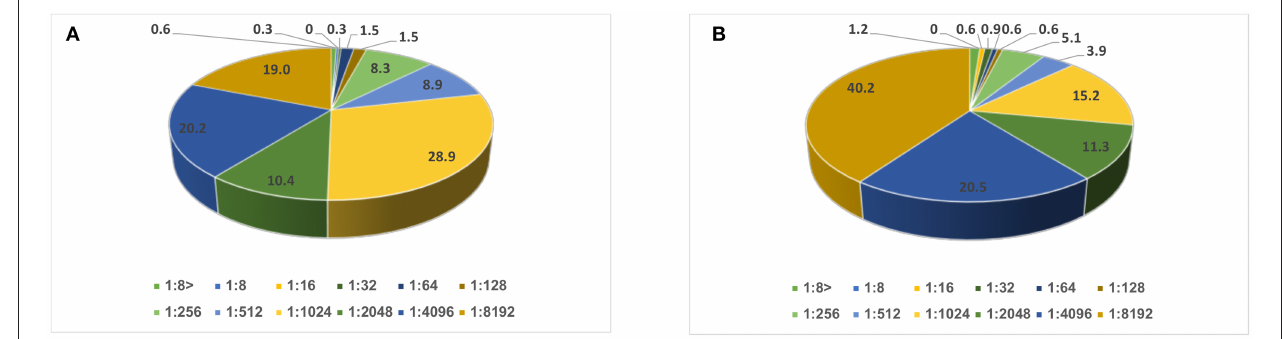
FIGURE 1 | Distribution of neutralizing antibody titer (in percentages): (A) against poliovirus type 1 and (B) type 3 vaccine strains among school age children ( N = 336).